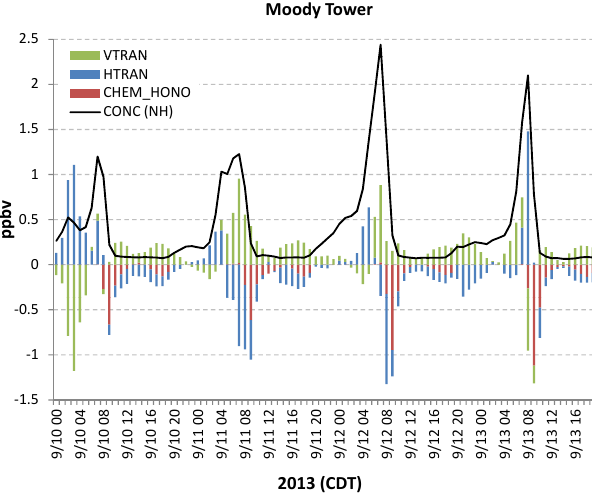
Figure 9. HONO mixing ratios (black line) and processes contribut- ing to changes in HONO mixing ratio at the Moody Tower site where the measurements were taken, which corresponds to the sec- ond model layer, where VTRAN is vertical transport, HTRAN is transport in horizontal direction, and CHEM_HONO corresponds to changes due to chemical